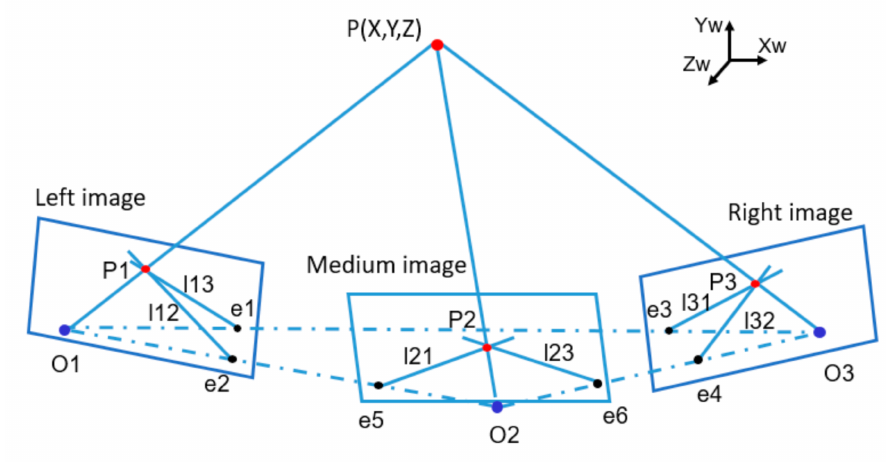
Figure 4. Schematic diagram of bipolar line constraints in